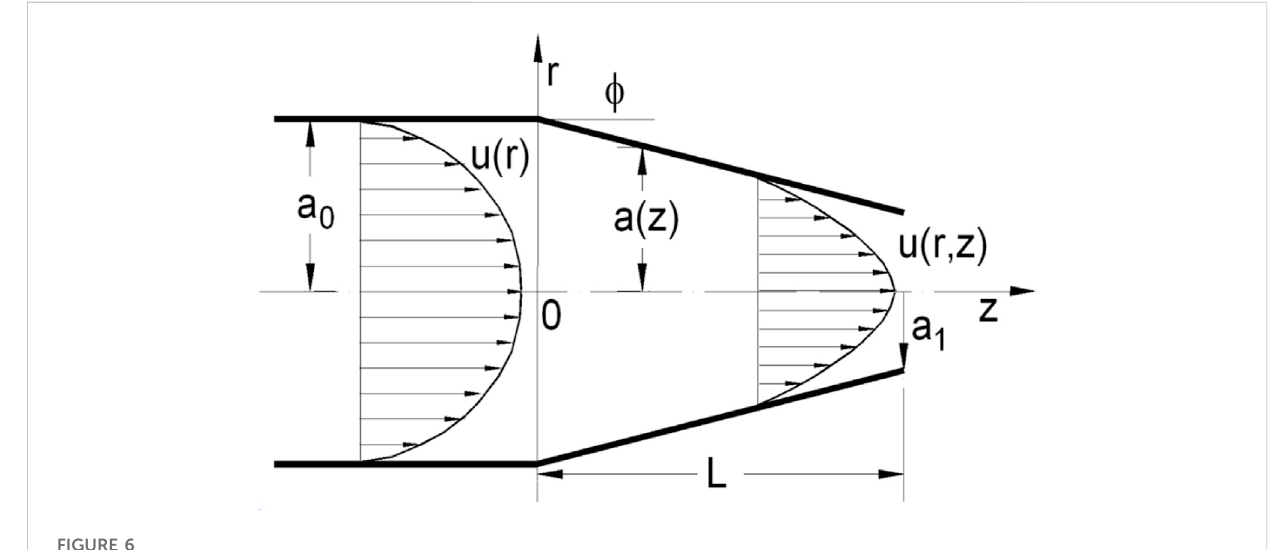
FIGURE 6 Schematic of varying the cross-section